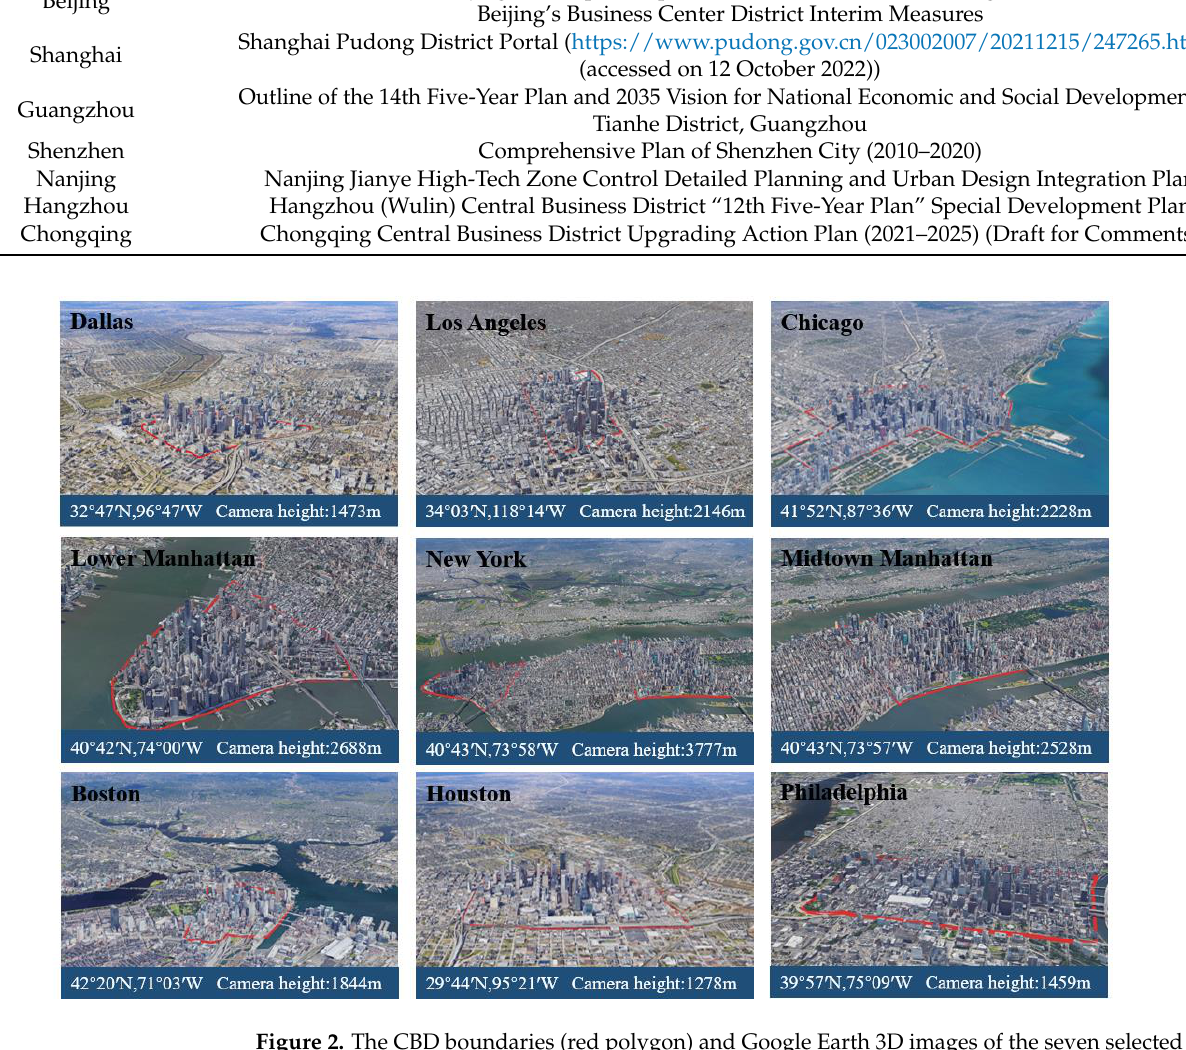
Figure 2. The CBD boundaries (red polygon) and Google Earth 3D images of the seven selected cities in the United States.